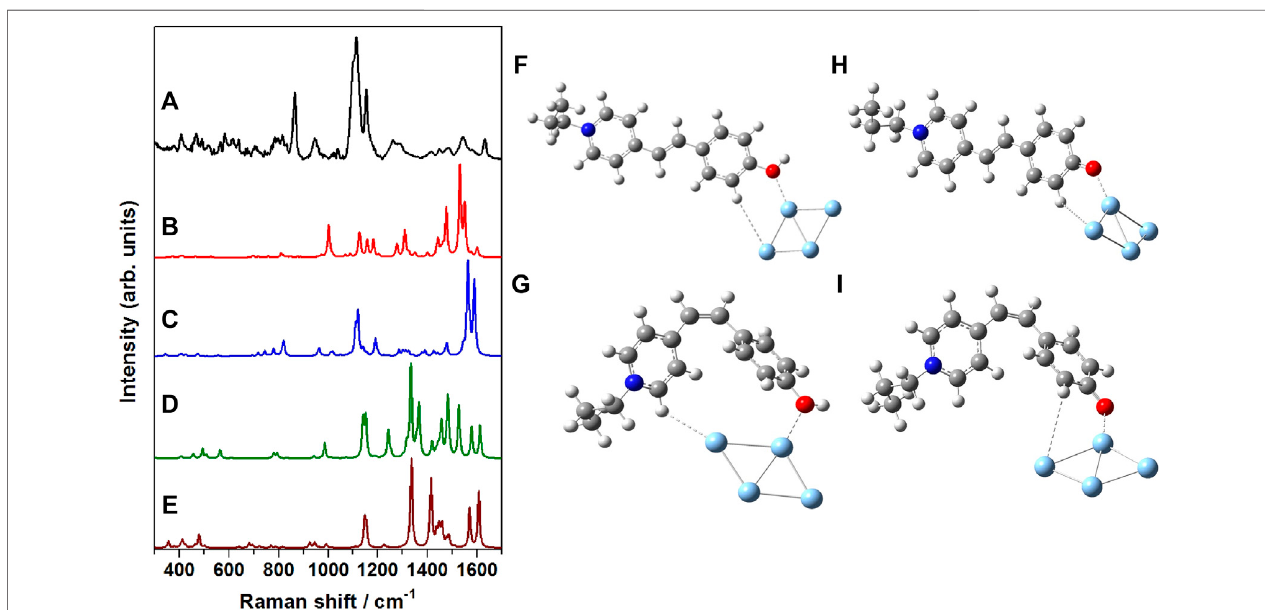
FIGURE 8 | (A) SERS spectrum of merocyanine dye (1 μ M) recorded at 785 nm excitation, B3LYP/6 – 31+G* computed Raman spectrum of (B) trans -MCH + -Ag 4 , (C) cis -MCH +